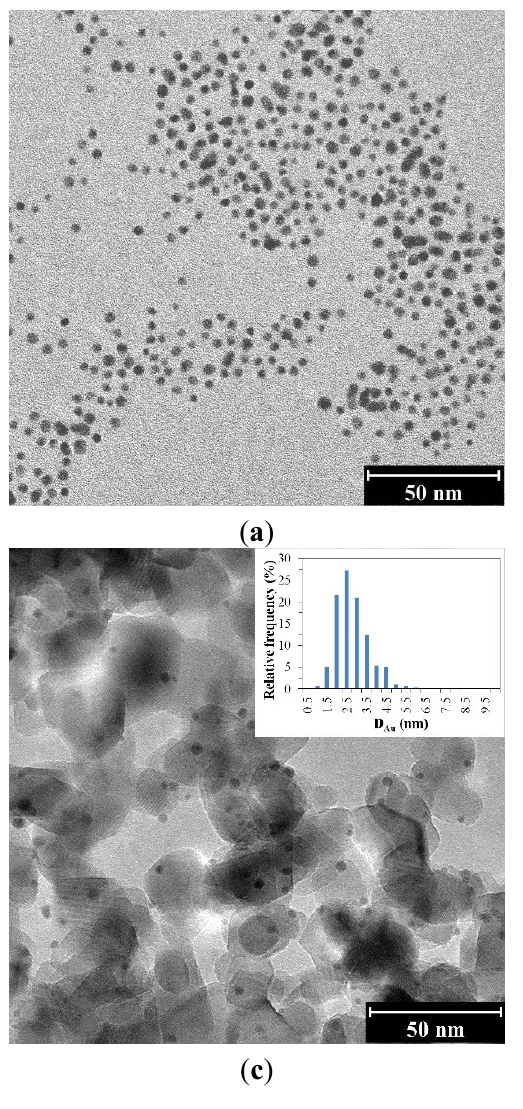
Figure 3. TEM images of ( a ) 5.00 × 10 −4 M TC-stabilized Au sol ( D Au = 2.9 nm); ( b ) 1.25 × 10 −4 M TC-stabilized Au-P25-CRIS ( D Au = 5.7 nm); ( c ) 5.00 × 10 −4